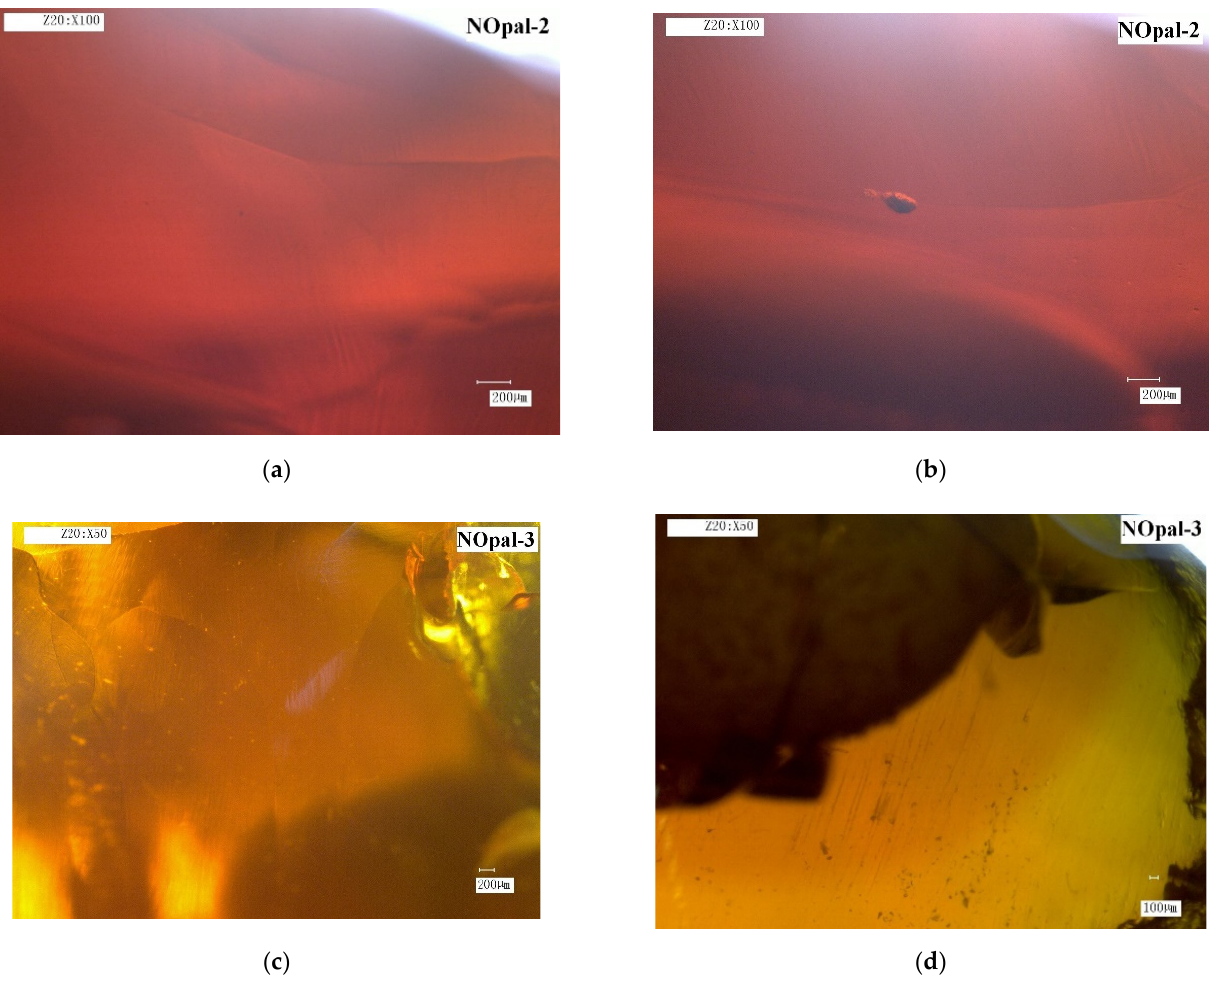
Figure 3. Digital micrographs of sample NOpal-2 and NOpal-3. ( a – c ) Even color distribution; ( d ) Color bands.